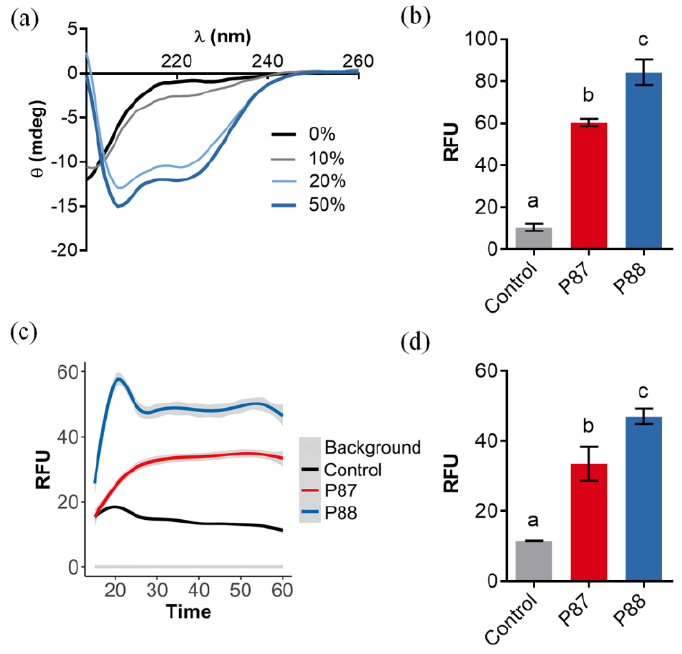
Figure 2. Ability of P88 to form amphipathic helices and permeabilize biological membranes. ( a ) Far-UV circular dichroism spectra of P88 in the presence of different concentrations of TFE. ( b ) Average NPN fluorescence signal after 5 min incubation in the presence of P. aeruginosa PAO1. ( c ) Average kinetics of SYTOX fluorescence in the presence of P. aeruginosa PAO1. Estimation was based on three independent replicates, mean estimation ± 95% C.I. (grey shade) is shown for each experimental condition. ( d ) Average SYTOX fluorescence at t = 60 min. In ( b , d ), means ± sd of three independent replicates are shown and a one-way ANOVA test with Tukey post-test was applied for multiple comparisons. Different letters indicate significant differences.